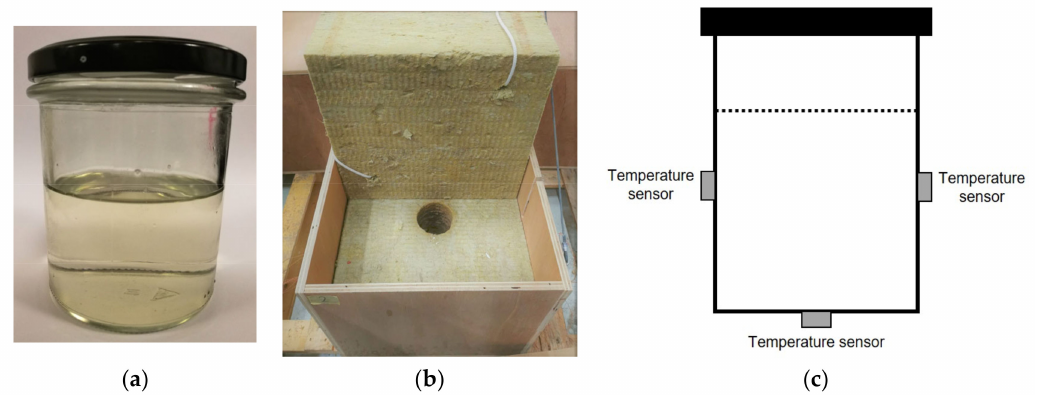
Figure 24. ( a ) Glass jar with lid, ( b ) the well-insulated box, ( c ) locations of temperature sensors (“DTU heat loss